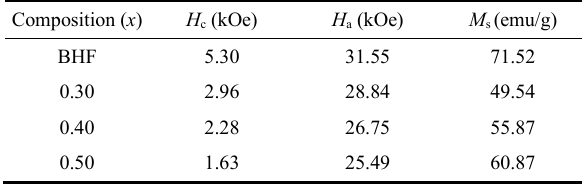
Table 2 Magnetic parameters of (1 ̶ x )KNN–( x )BHF ( x = 30, 40, and 50 wt%) composites